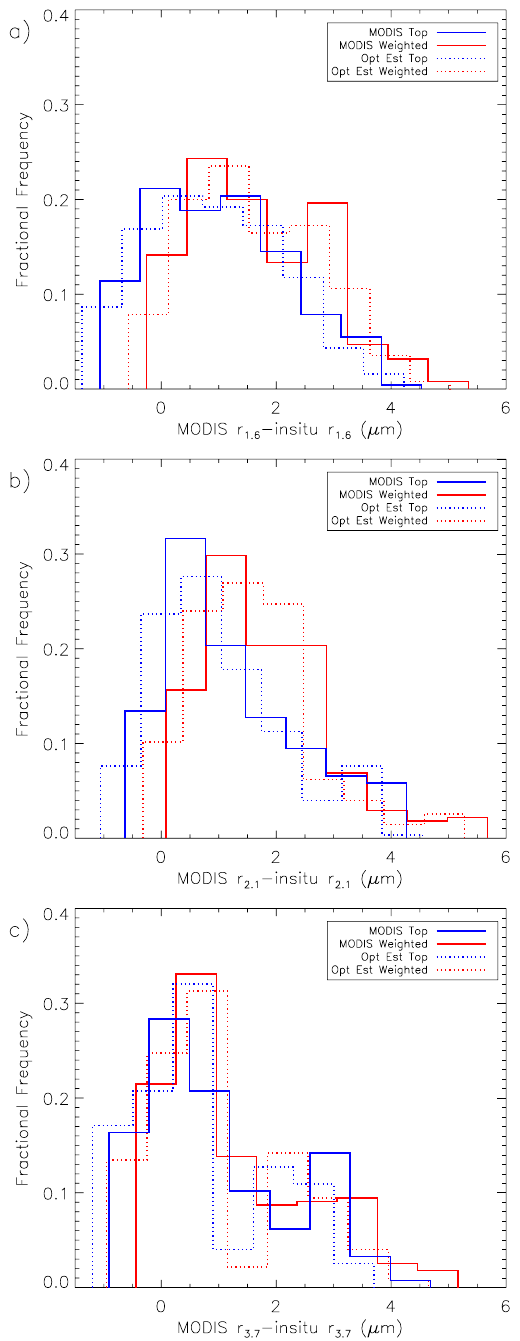
Fig. 13. Differences between r e retrievals for all MODIS pixels used in the comparison analysis and their corresponding in situ matched values.